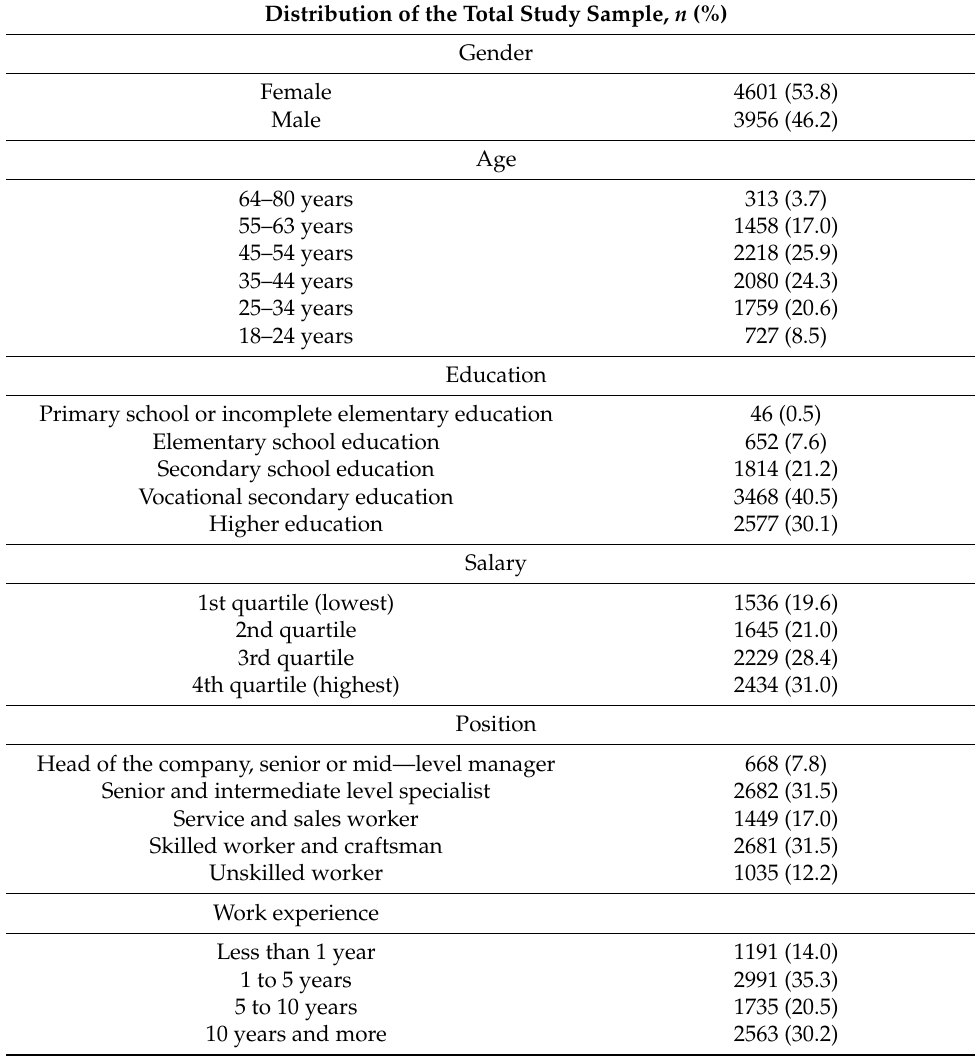
Table A1. Socio-demographic characteristics of the study sample.